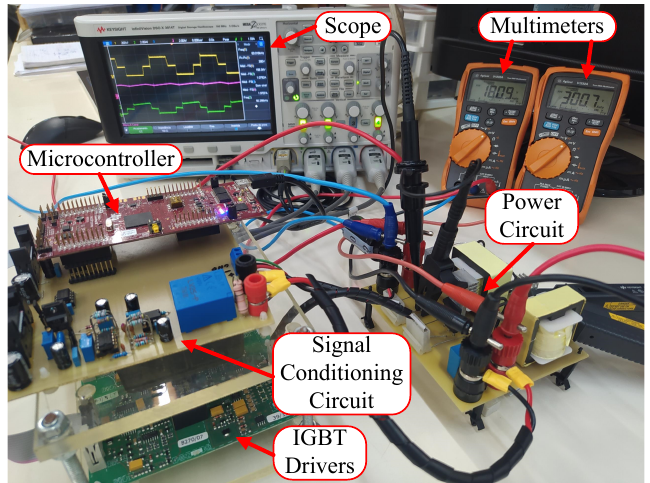
Figure 7. Experimental set-up.